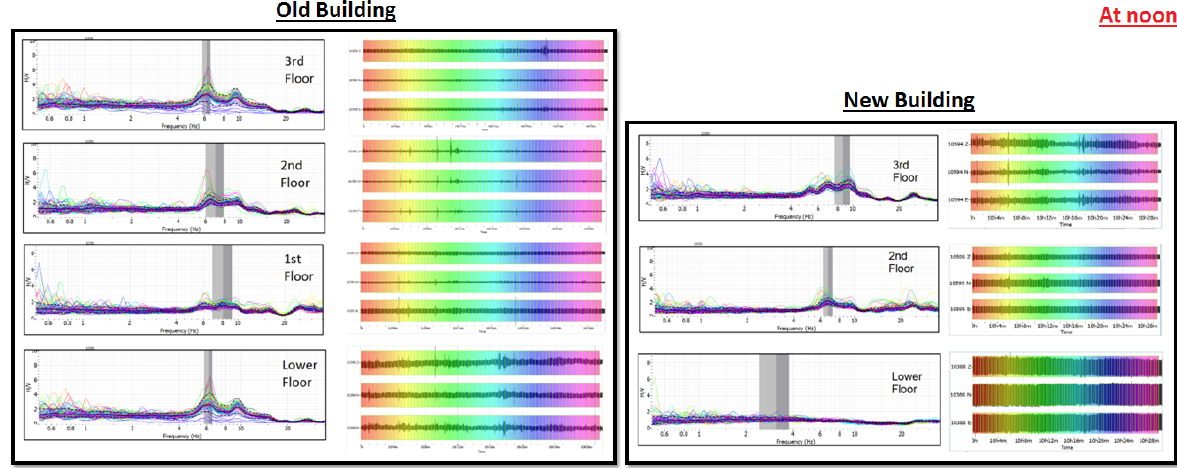
Figure 15. Programmed 30min HVSR recordings on 8 May 2013, 10:00UMT (8 May 2013, 13:00LT) on the old building of TEI. On the right is the presentation of 25s time duration windows which are extended in the whole length of the recording.